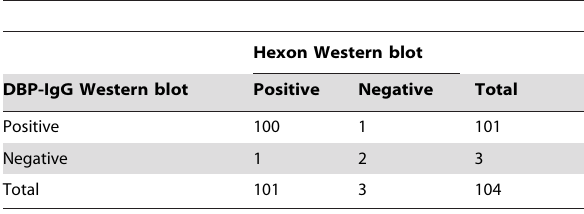
Table 3. Comparison of DBP-IgG Western blot and hexon Western